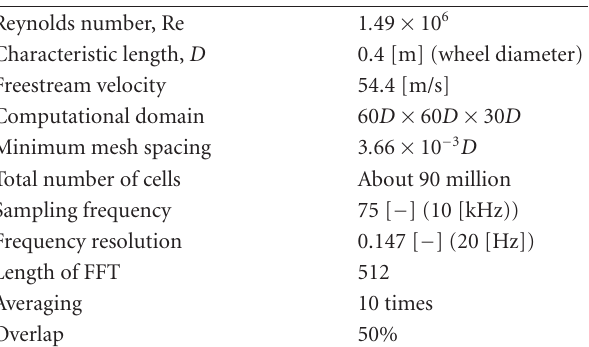
Figure 11: Comparison of OASPL of di ff erent LEG configurations. Table 3: Computational condition of LEG